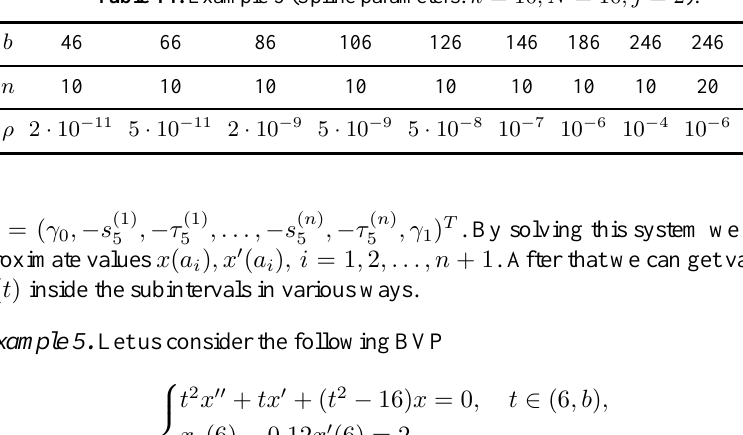
Table 14. Example 5 (Spline parameters: k = 10 ; N = 10 ; j = 2